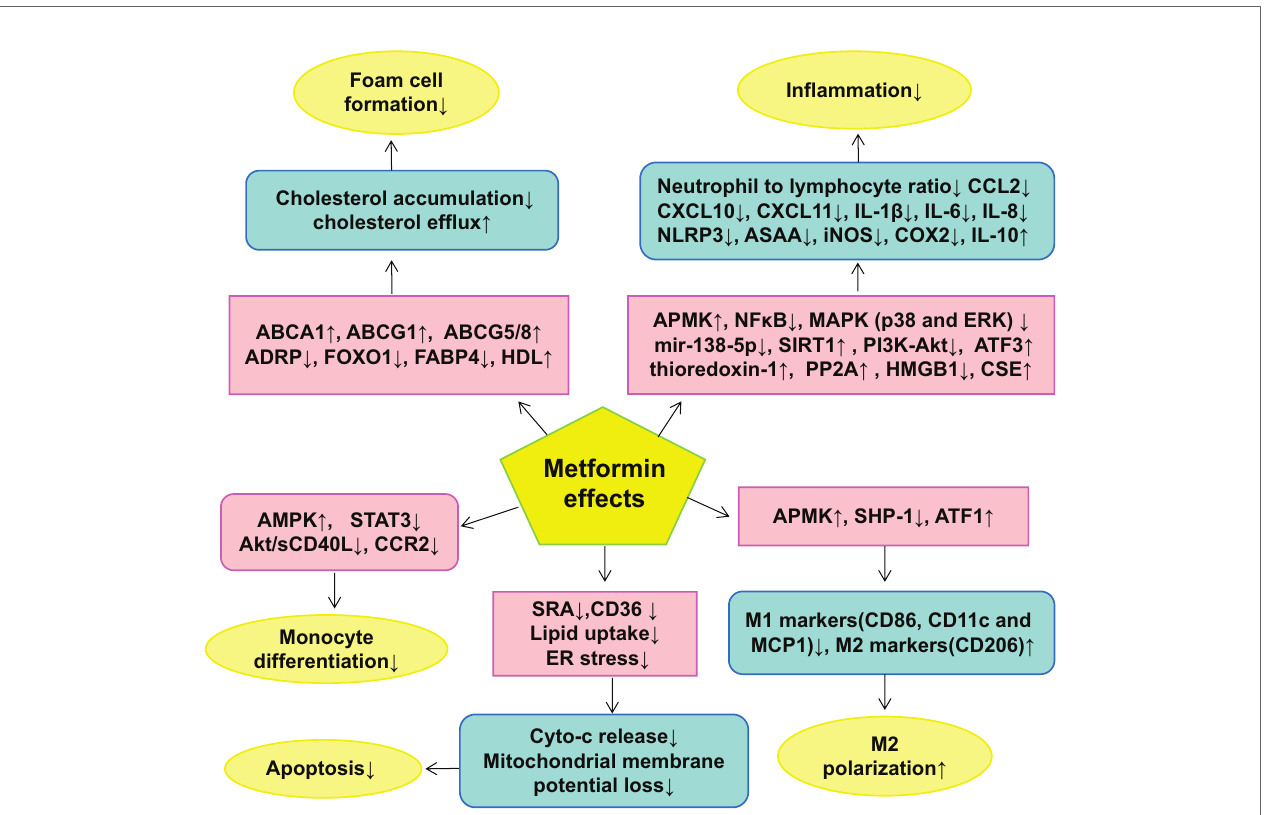
FIGURE 3 | The effect of metformin on monocyte/macrophage functions in AS. Metformin inhibits monocyte/macrophage dysfunction via modulating the expression and activity of genes or proteins closely related to monocyte differentiation, macrophage in fl ammation, M1/M2 polarization, foam cell formation and macrophage apoptosis. ↑ indicates increase or activation, and ↓ indicates decrease or suppression. ABCA1, ATP-binding cassette transporter A1; ABCG1, ATP-binding cassette transporter G1; ABCG5/8, ATP-binding cassette transporter 5/8; ADRP, adipogenic differentiation-associated protein; Akt, protein kinase B; AMPK, 5 ’ -adenosine monophosphate-activated protein kinase; ASAA, acute-phase serum amyloid A; ATF, Activation of transcription factor; CCL2, C-C motif chemokine ligand 2; CCR2, CC chemokine receptor 2; CD, cluster of differentiation; CXCL, Chemokine C-X-C ligand; CSE, Cystathionine g -lyase; cyto-c, cytochrome c; ER, endoplasmic reticulum; ERK, Extracellular signal-regulated kinase; FABP4, Fatty acid binding protein 4; FOXO1, Forkhead box transcription factor O1; HDL, high-density lipoprotein; HMGB1, high mobility group box-1; iNOS, inducible nitric oxide synthase; IL, Interleukin; MAPK, mitogen-activated protein kinase; MCP1, Monocyte chemoattractant protein 1; NF- k B, nuclear factor kappa B; NLRP3, NOD-like receptor family pyrin domain containing 3; PI3K, phosphatidylinositol 3-kinase; PP2A, protein phosphatase 2A; sCD40L soluble CD40 ligand; SH2, Src homology 2; domain-containing protein tyrosine phosphatase 1(SHP-1), SIRT1, Sirtuin-1; SRA, scavenger receptor class A; STAT3, Signal transducer and activator of transcription